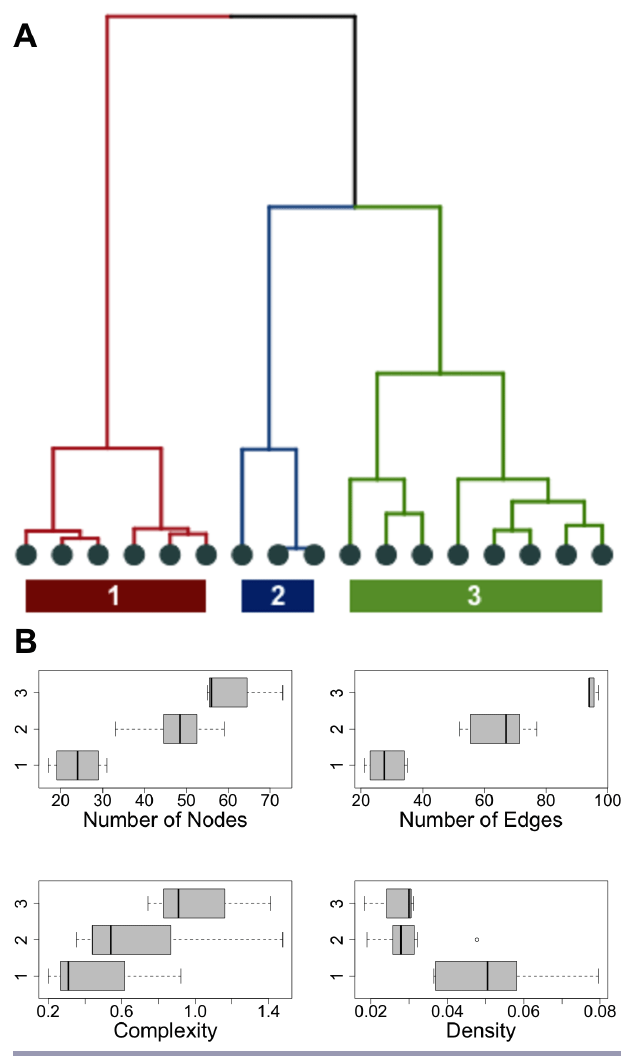
Fig. 3 . (A) Hierarchical cluster analysis of individual network maps based on structural metrics, and including all four edge types, revealed three major clusters. Branch distance is proportional to similarity of individual network structure. (B) Network clusters are based on analysis of four network metrics, plotted in box and whisker plots.